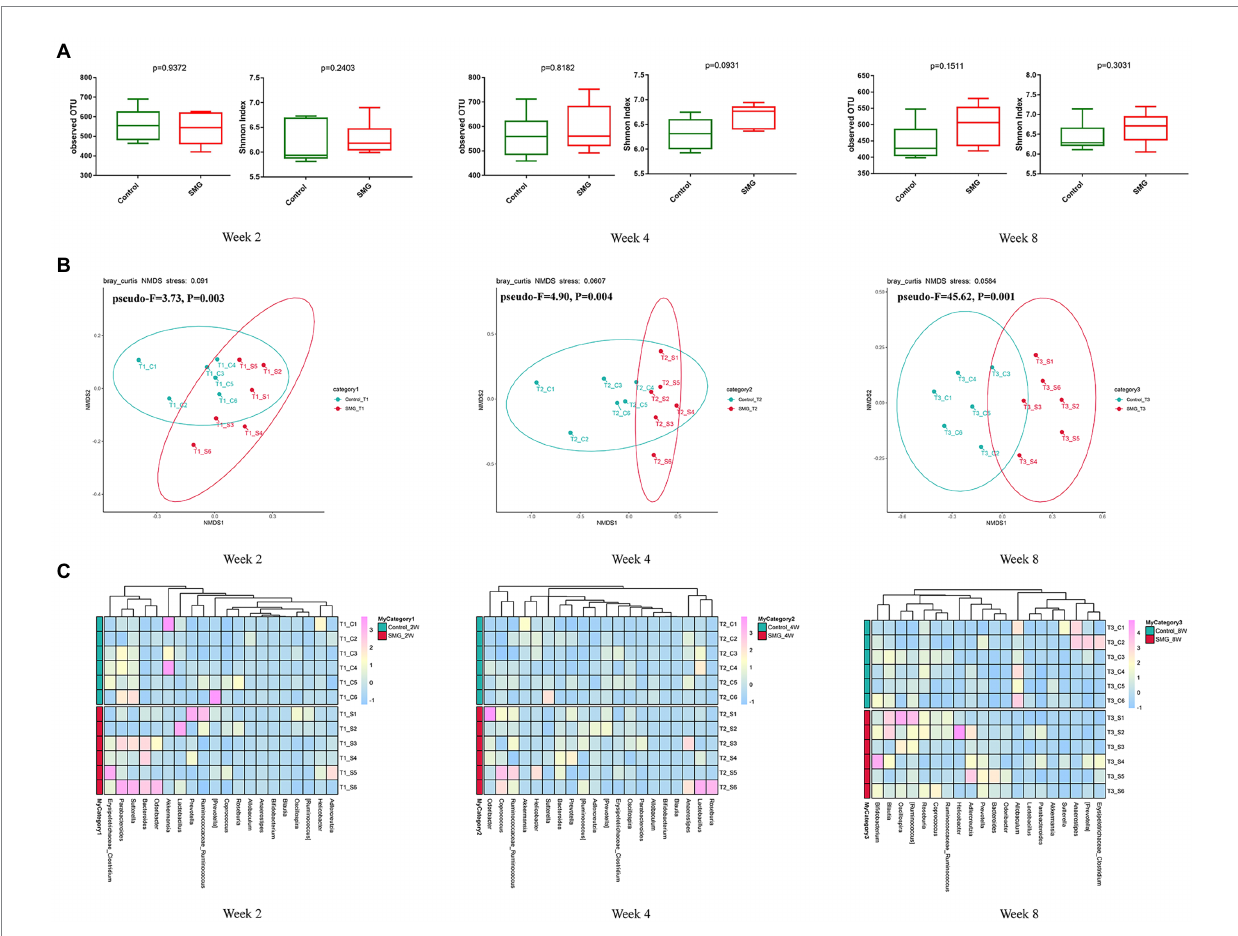
FIGURE 1 Bacterial diversity analysis of the gut microbiota in two groups during SMG treatment. (A) Alpha diversity metrics (observed OTU and Shannon indices) with respect to SMG and control at week 2, 4 and 8. (B) Beta diversity of the gut microbiota in two groups at week 2, 4 and 8. (A) The NMDS plot of gut microbiota from the control and SMG group at three time point intervals. (C) Heatmap of the relative abundance of top 20 bacterial genera at three time